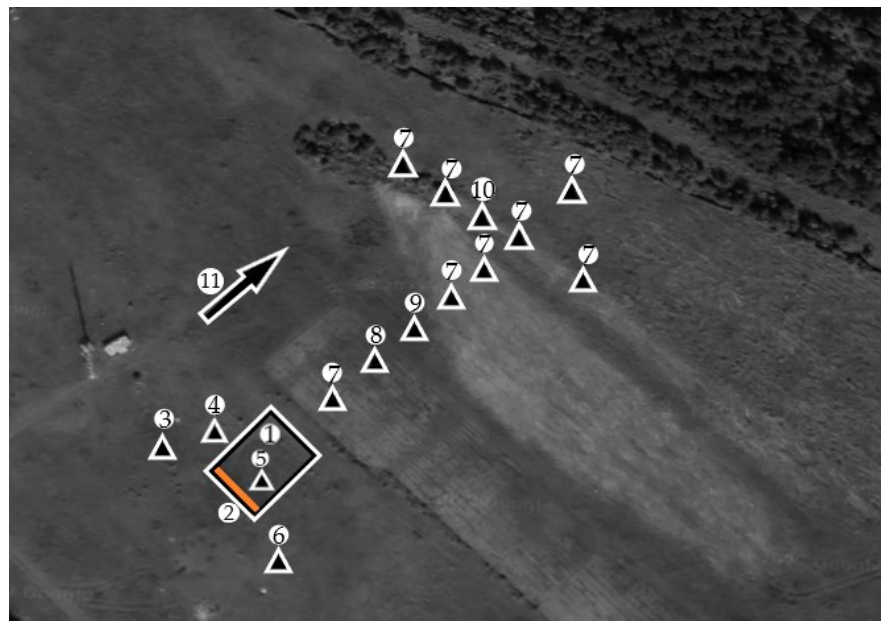
Figure 1. Satellite image of the BEC and the experimental site areas with measuring equipment: (1) experimental area, 10 × 4 m; (2) ignition line; (3) monitoring and recording equipment (PC and data logger “ZET LAB”); (4) JADE J530SB IR camera; (5) rack with thermocouples; (6) video camera; (7) rack with aerosol sensors; (8) AMK-03 weather station on a 3 m mast; (9) AMK-03 weather station on a 10 m mast; (10) AMK-03 weather station on a 6 m mast; (11) predominant wind direction during the experiment.